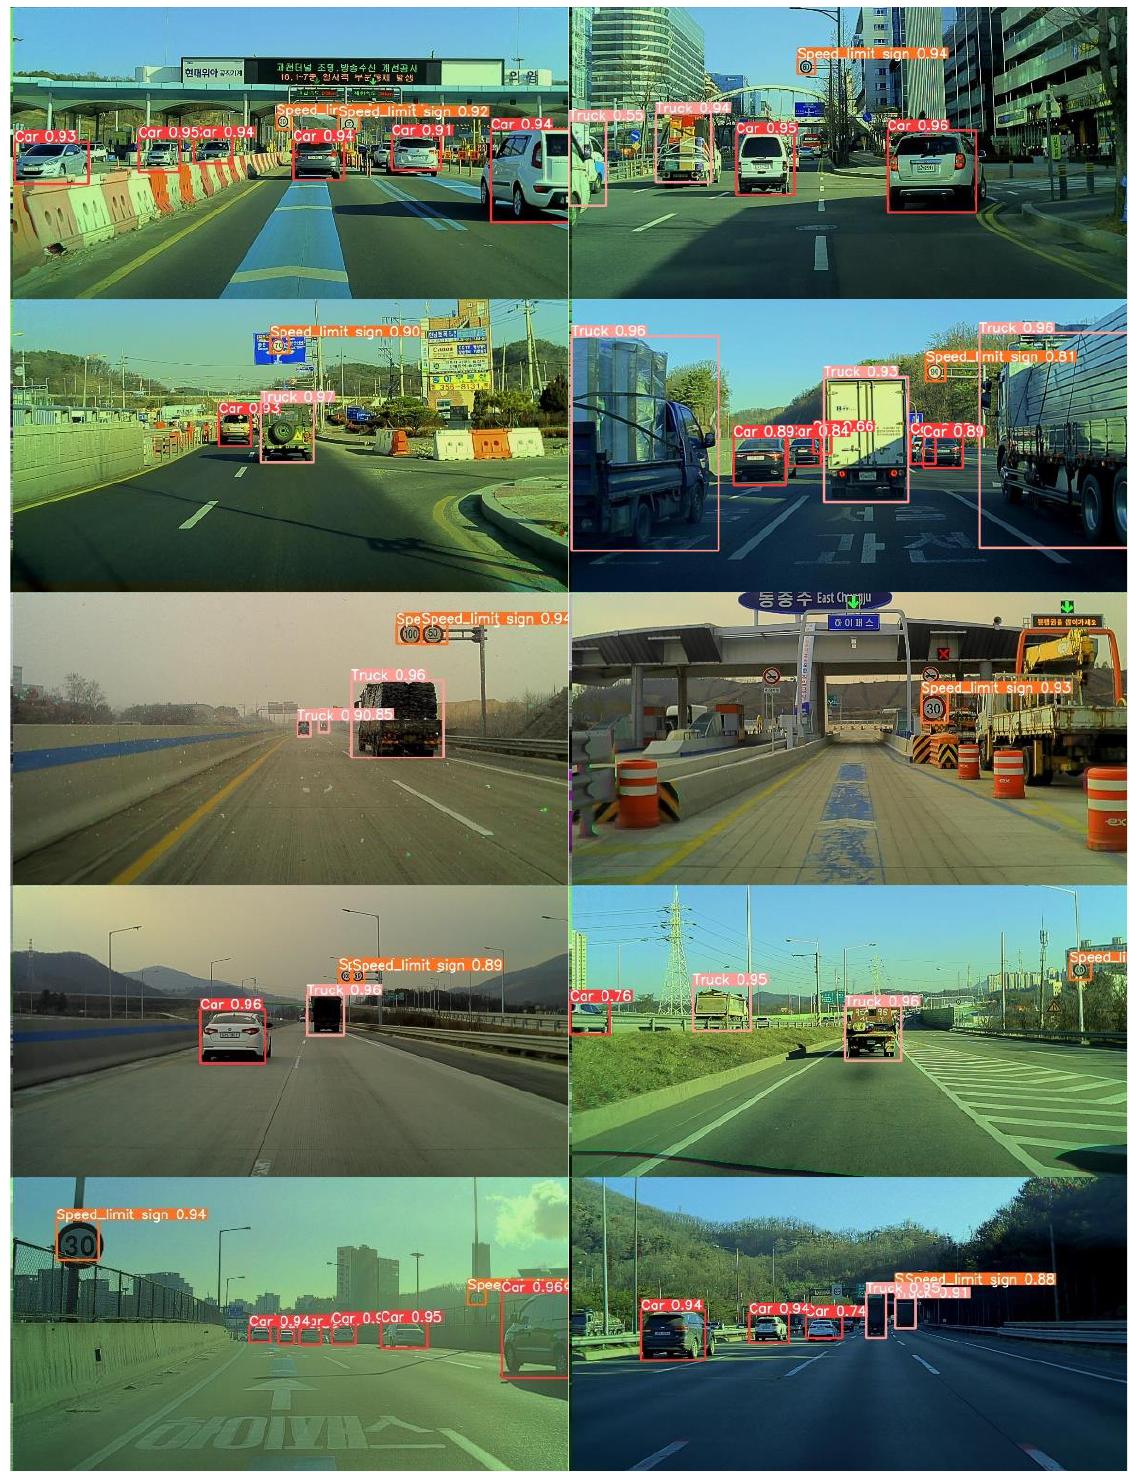
Figure 10. Various object detection results in different scenarios on